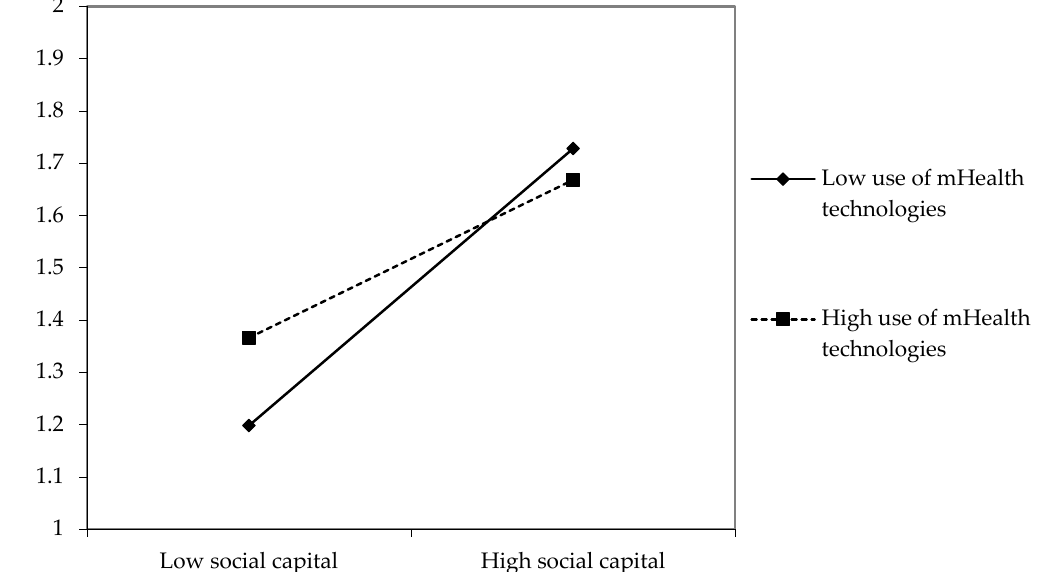
Figure 5. Interaction effects between social capital and use of mHealth technologies on health status.